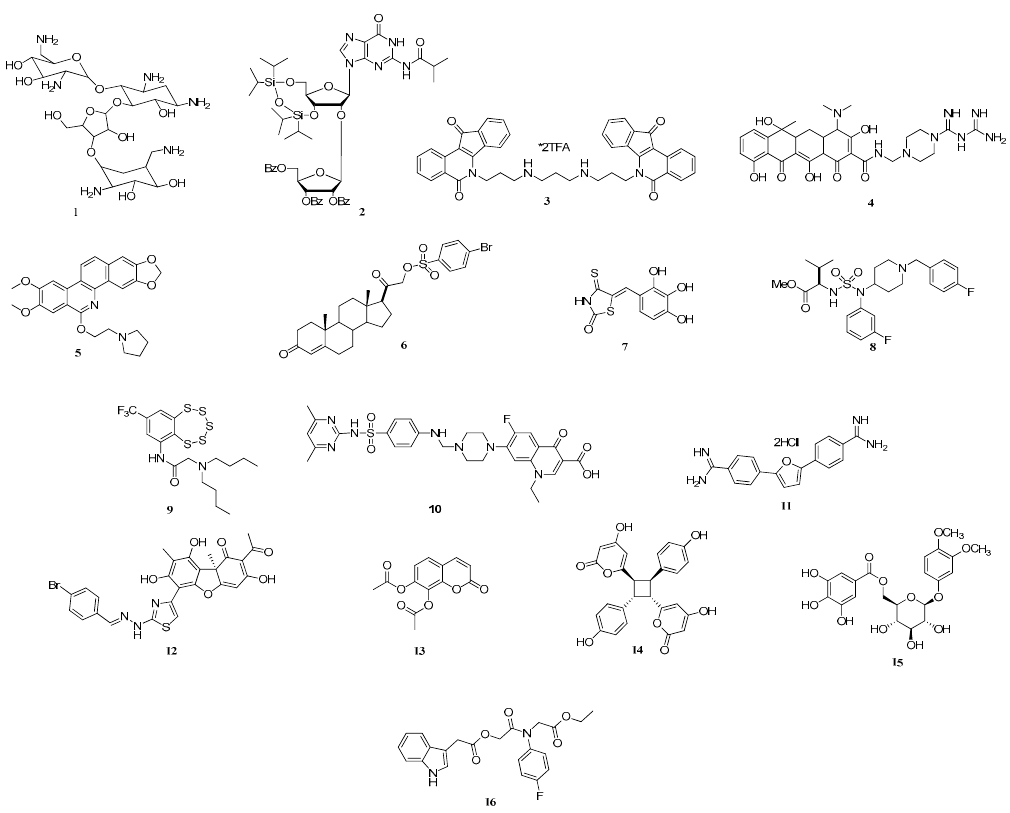
Figure 1. The chemical structures of known Tdp1 inhibitors, a remarkable diversity is accommodated by the enzyme.